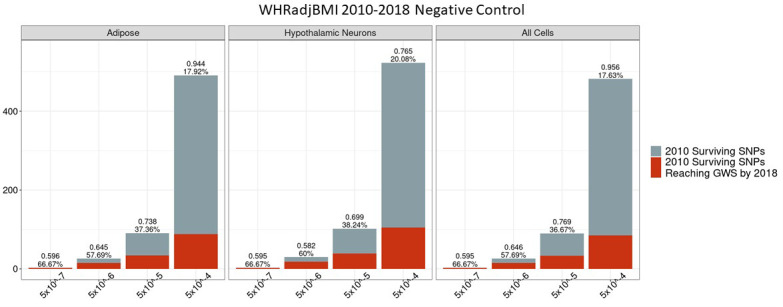
Independent 2010.WHRadjBMI SNPs failing the variant-to-gene mapping filter that go on to reach genome-wide significance by 2018. Positive predictive value is depicted for each bar. The posterior probability that loci identified by our chromatin-based constraint more often achieve GWS than loci with no constraint is posted above these percentages. There is no threshold where this data differs significantly from the unconstrained set.Figure 8—source data 1.Number of 2010 loci identified by constrained method and the number that achieved GWS by 2018 in each cell type.